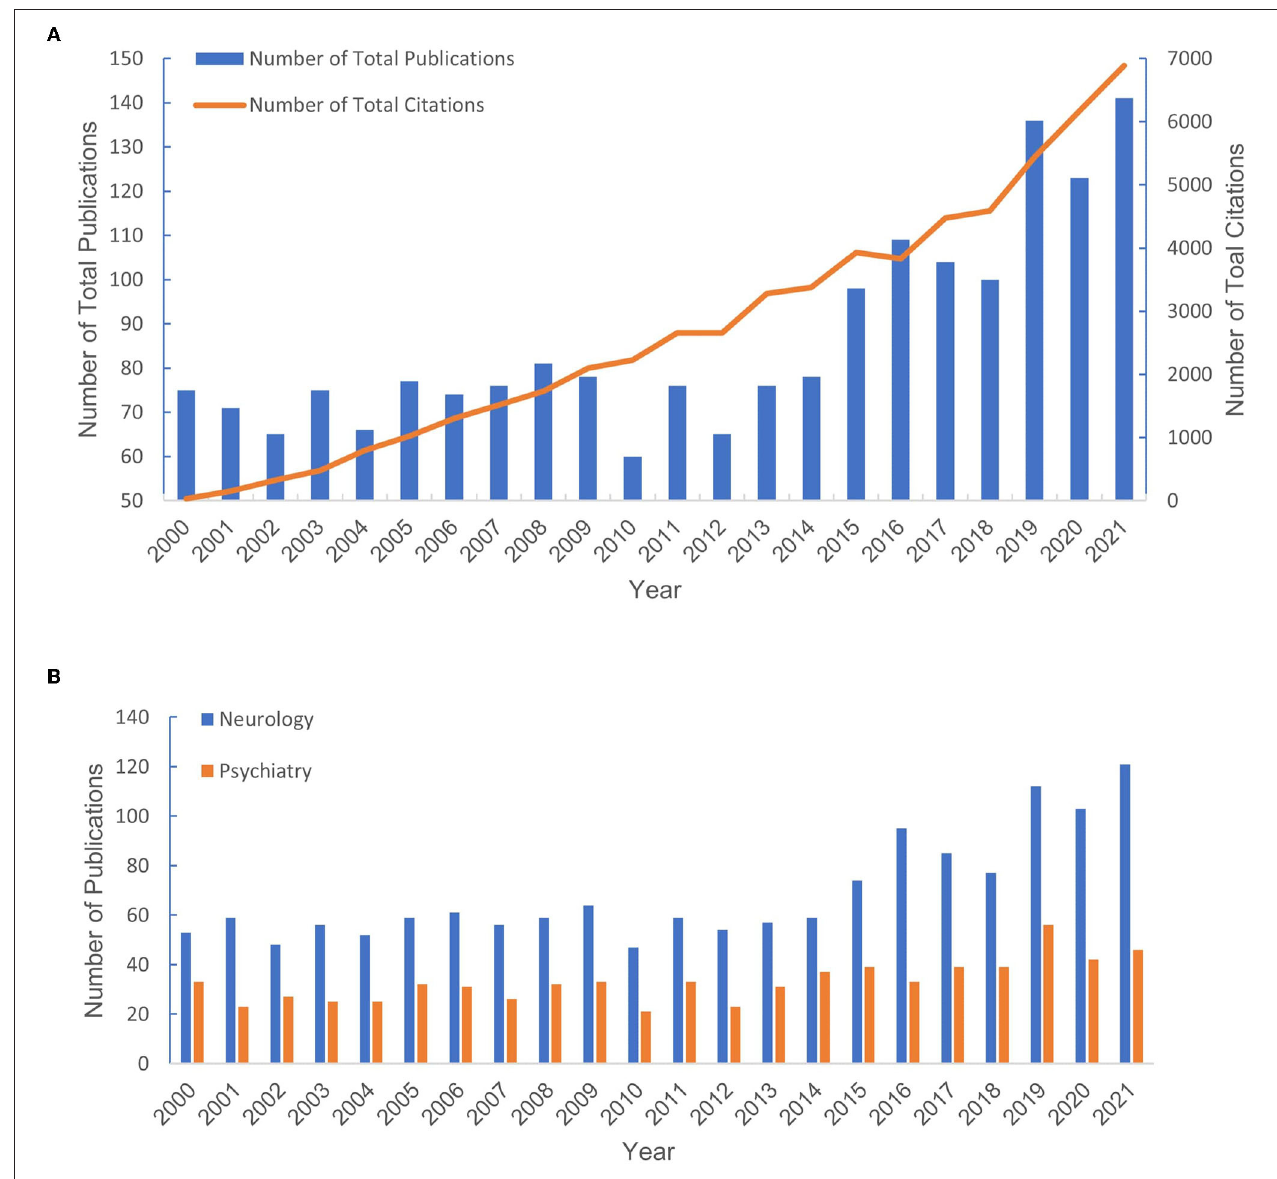
FIGURE 2 | The number of publications from 2000 to 2021. (A) The number of publications in neurology and psychiatry. (B) The total number of publications and the percentage of total